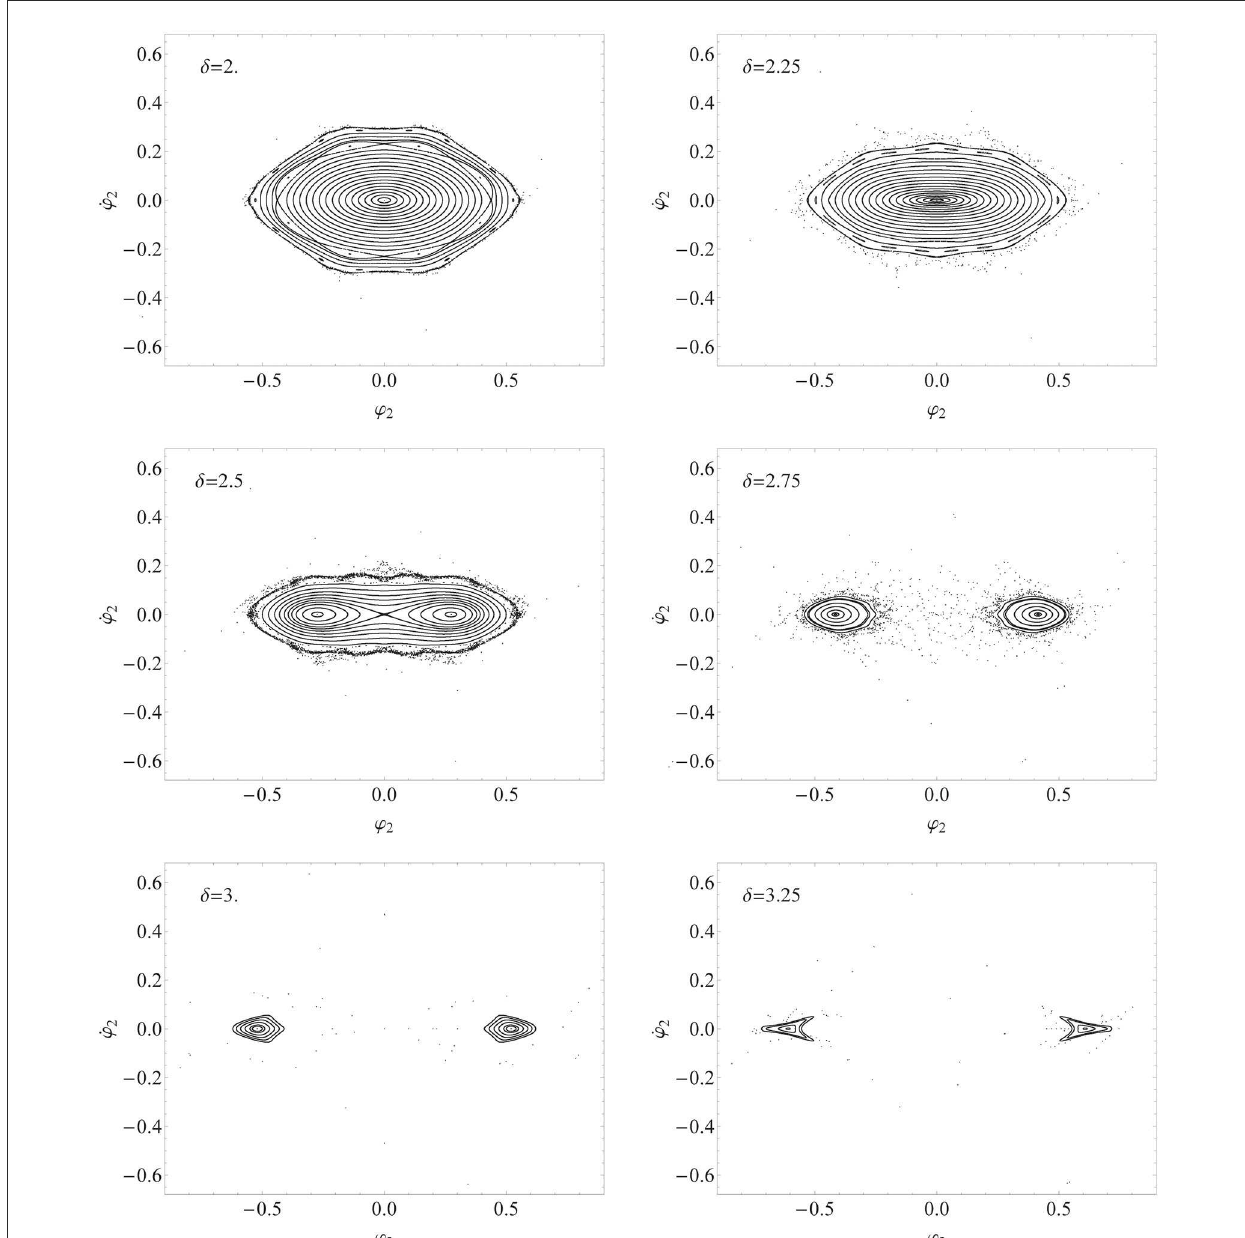
FIGURE8 Poincaré maps in the displacement-velocity phase plane for several sets of initial conditions, see Equation (40), and load amplitude δ from two times the value of the first critical load ( δ = 2.) up to δ = 3.25, at fixed load frequency ( (cid:127) = 4.0).